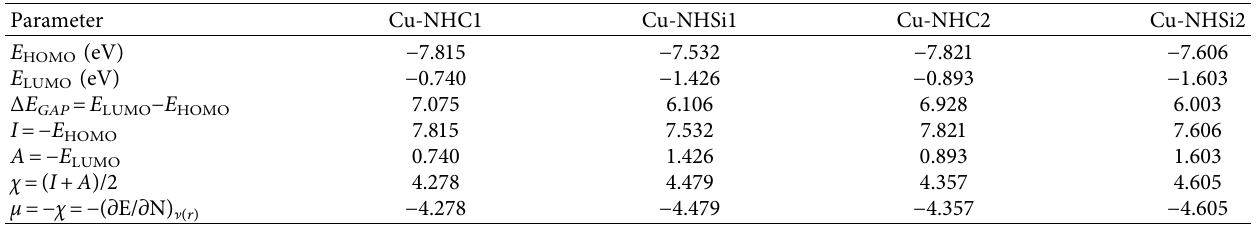
Figure 5: HOMO and LUMO of copper tetrylenes, Cu-NHC1, Cu-NHSi1, Cu-NHC2, Cu-NHSi2, calculated by DFTat the level of theory BP86/def2-TZVPP. Table 2: Quantum chemical parameters of copper carbenes and copper silylenes, Cu-NHC1, Cu-NHC2, Cu-NHSi1, and Cu-NHSi2, calculated by NBO analysis at the level of theory BP86/def2-TZVPP.